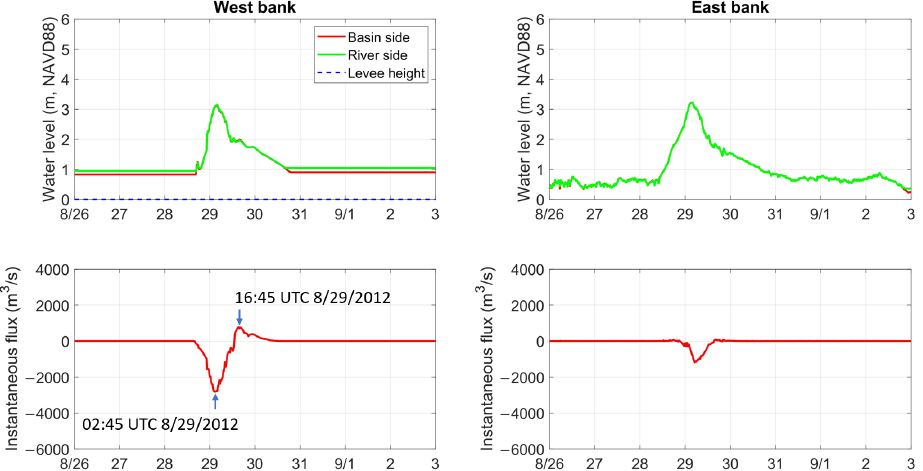
Figure 10. Time series of water level (m, NAVD88, top) and instantaneous flux (m 3 /s, bottom) for the west (left) and east (right) banks at the lower-crossing location in the both-crossing case during Isaac (2012). The direction of positive flux is from west to east.